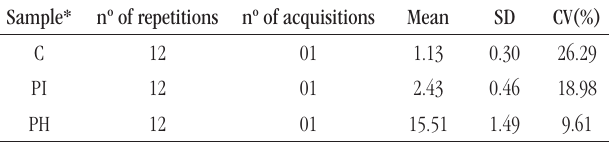
tABLE 1 – Accuracy of reticulocyte count by the manual method Sample* nº of repetitions nº of acquisitions